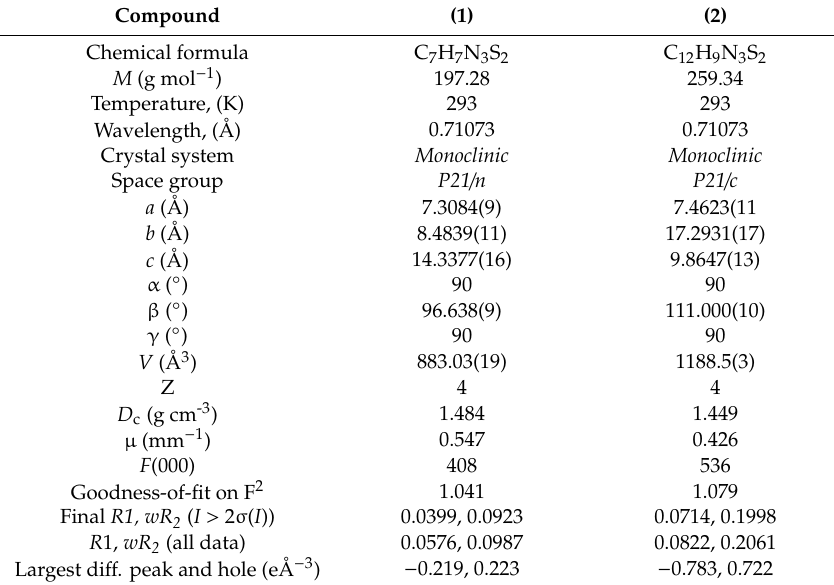
Figure 3. The molecular structure with atom numbering for ( 1 ).